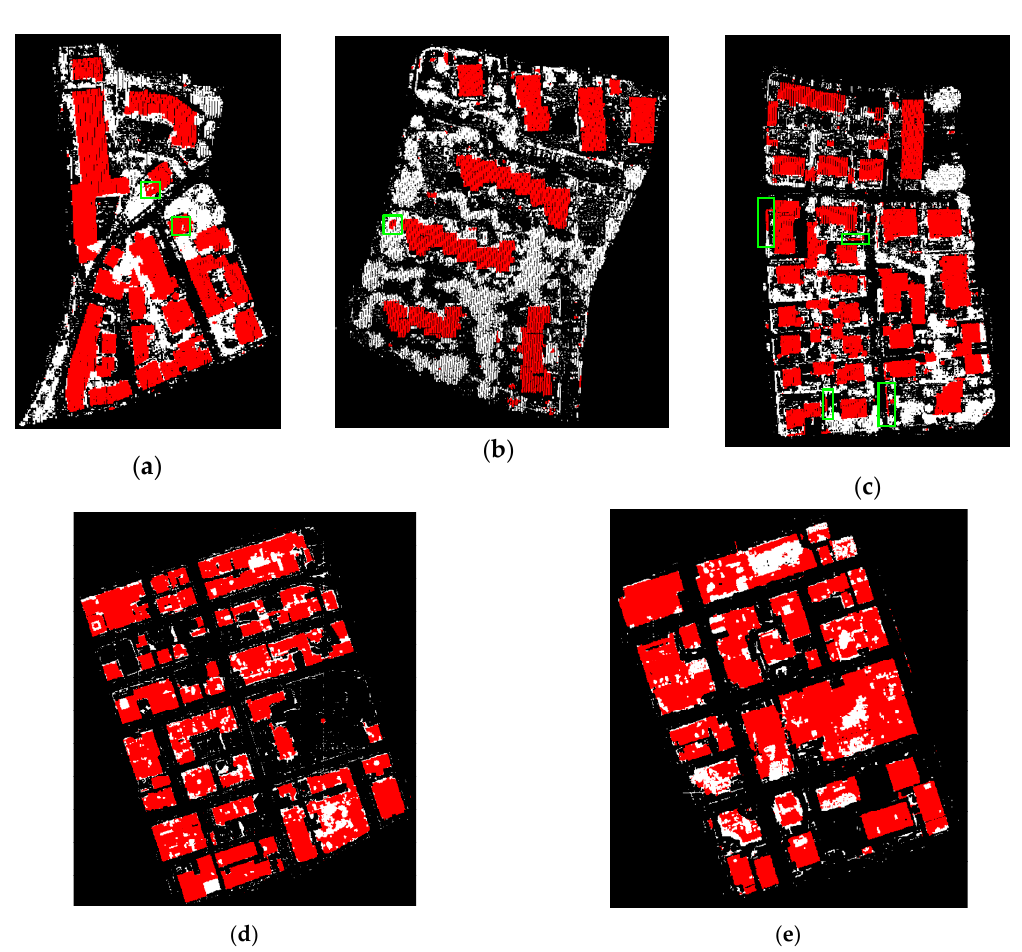
Figure 10. Initial results of building extraction based on graph cuts and height constraints. ( a ) Results of Area 1; ( b ) Results of Area 2; ( c ) Results of Area 3; ( d ) Results of Area 4; ( e ) Results of Area 5. For qualitative evaluation, four indicators: completeness CP (%), correctness CR (%), quality Q (%) and 𝐹 (cid:2869) -score 𝐹 (cid:2869) (%) metrics of the results on per-area and per-object levels are evaluated [37,63–